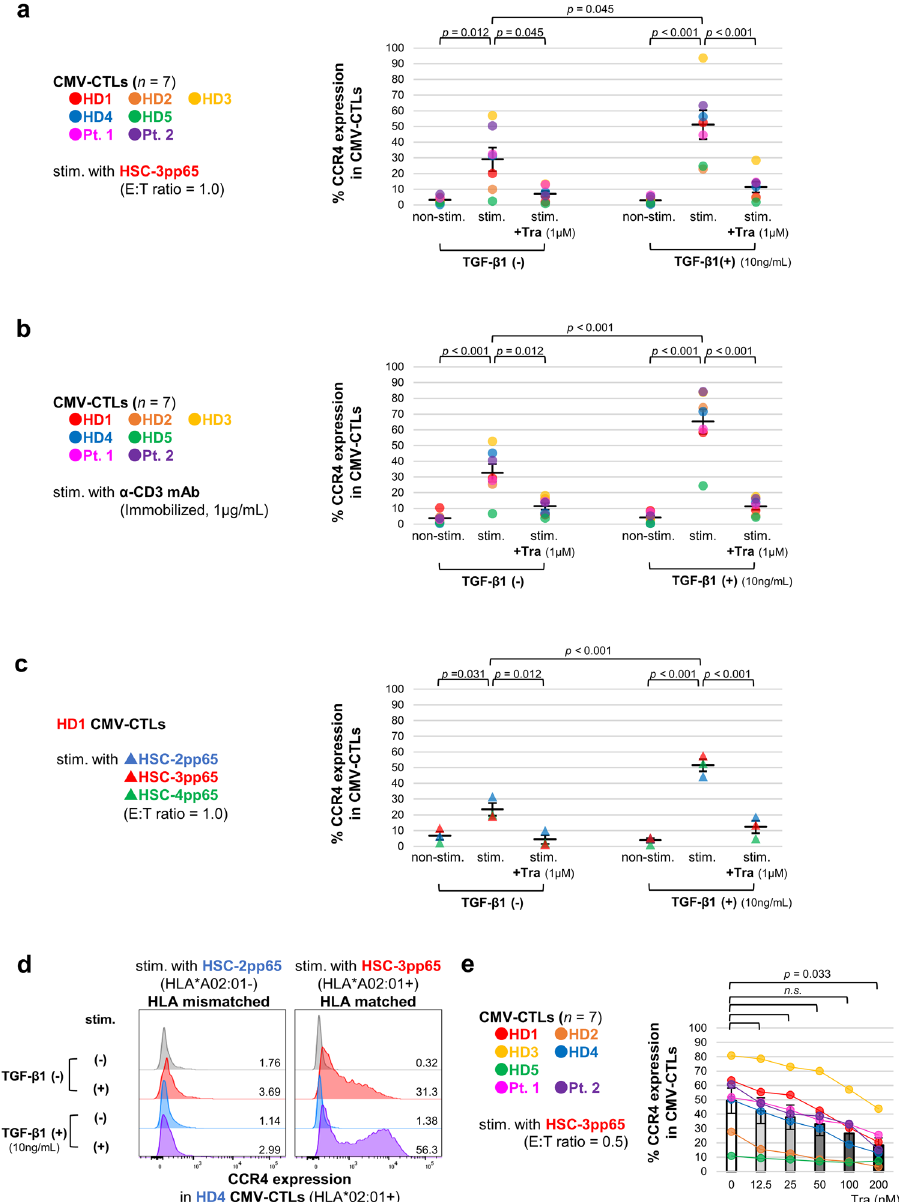
Figure 2. CCR4 expression in CTLs was induced by antigen-specific TCR stimulation, enhanced by TGF- β1, and suppressed by trametinib. CMV-CTLs were stimulated with HSC-2pp65, HSC-3pp65, HSC-4pp65, and immobilized anti-CD3 mAb. The E:T ratio was adjusted to 1.0 ( a , c , d ) and 0.5 ( e ). 10 ng/mL TGF-β1 and 1 μmol/L ( a–d ) or serial concentration ( e ) trametinib were added. CCR4 expression in CMV-CTLs was evaluated by flow cytometry on day 2. CCR4 expression in CTLs stimulated by HSC-3pp65 (( a ), n = 7, independent donors), by anti-CD3 mAb (( b ), n = 7, independent donors), by three different OSCC cell lines (( c ), n = 3, independent cell lines) are shown. HLA*A02:01-restricted CMV-CTL derived from HD4 was co-cultured with HLA-mismatched HSC-2pp65 and HLA-matched HSC-3pp65. The respective CCR4 expression is shown in ( d ). Concentration-dependent effects of trametinib to downregulate CCR4 expression in CTLs co-cultured with HSC-3pp65 without TGF-β1 are shown (( e ), n = 7, independent donors). Error bars indicate standard Table S1. Pt. patient, E:T ratio effector to target ratio, Tra trametinib, mAb monoclonal antibody, nM nmol/L, n.s. not significant, HLA human leukocyte